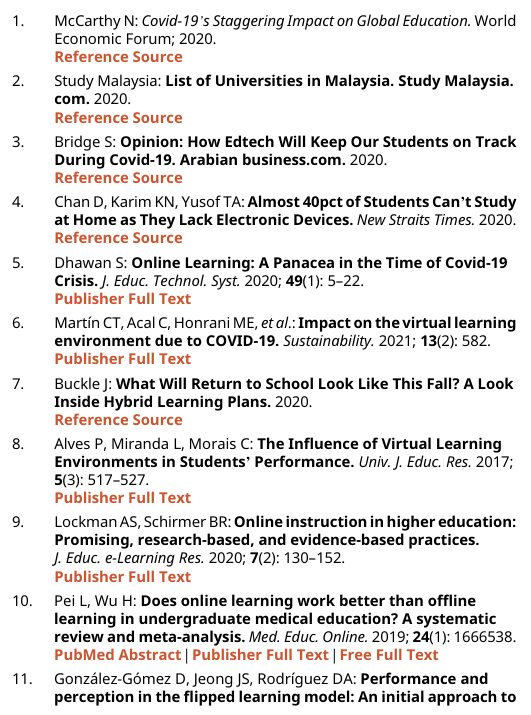
Figshare: An Empirical Study on the Impact of Virtual Learning on Multimedia University Student Performance.csv, https://doi.org/10.6084/m9.figshare.14872782.v4. 46